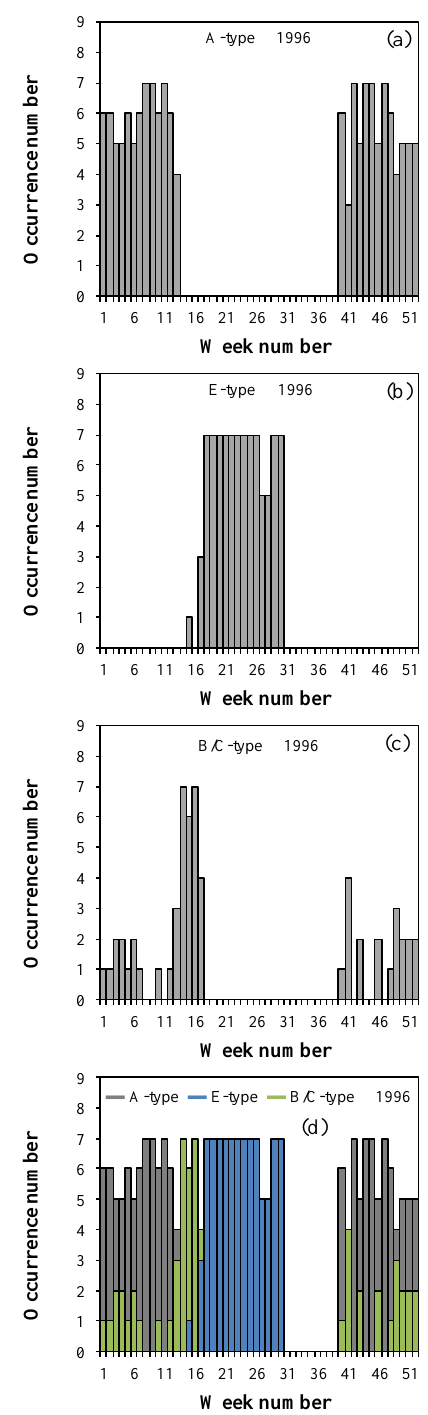
Figure 5. Same as Fig. 4 but for 1996, with clear seasonal be- haviours of the F-layer patterns except with regard to the secondary season of the B/C type during the period of November–December in (c) . In (d) , the large gap within weeks 31–39 is due to the ionosonde